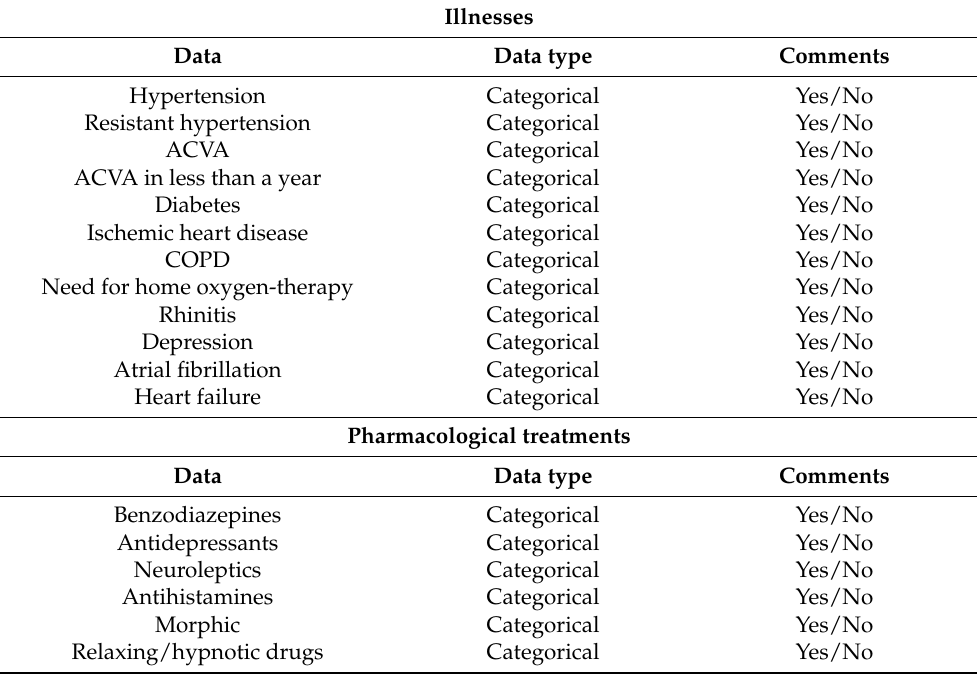
Table 4. Information related to illnesses and pharmacological